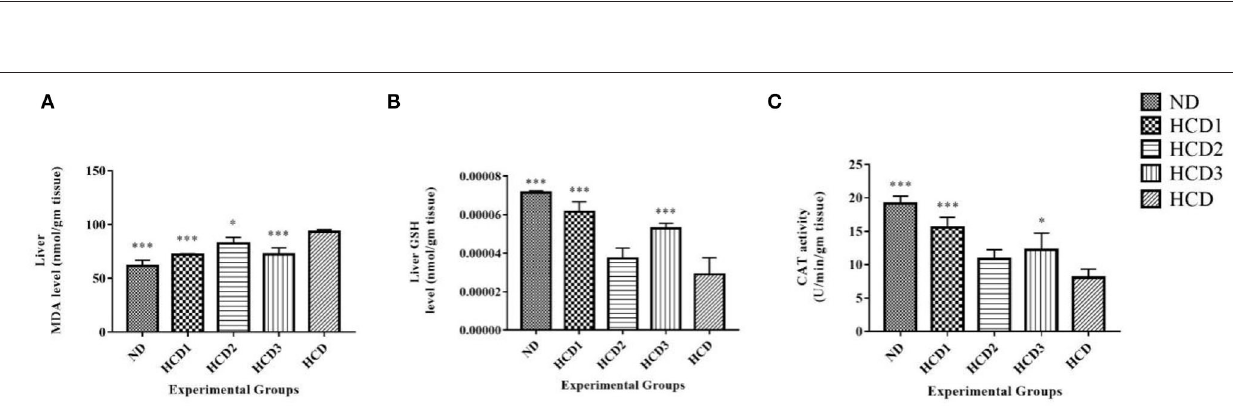
FIGURE 9 | Effect of probiotic strains on MDA, GSH, and CAT levels in the liver of high-fat diet fed rats. (A) Liver MDA level. (B) Liver GSH level. (C) Liver CAT activity. Analysis was done by One-way ANOVA followed by Dunnett’s post-hoc test where ***indicates p ≤ 0.001 and *indicates p ≤ 0.05. All data represented as mean ± SD of 6